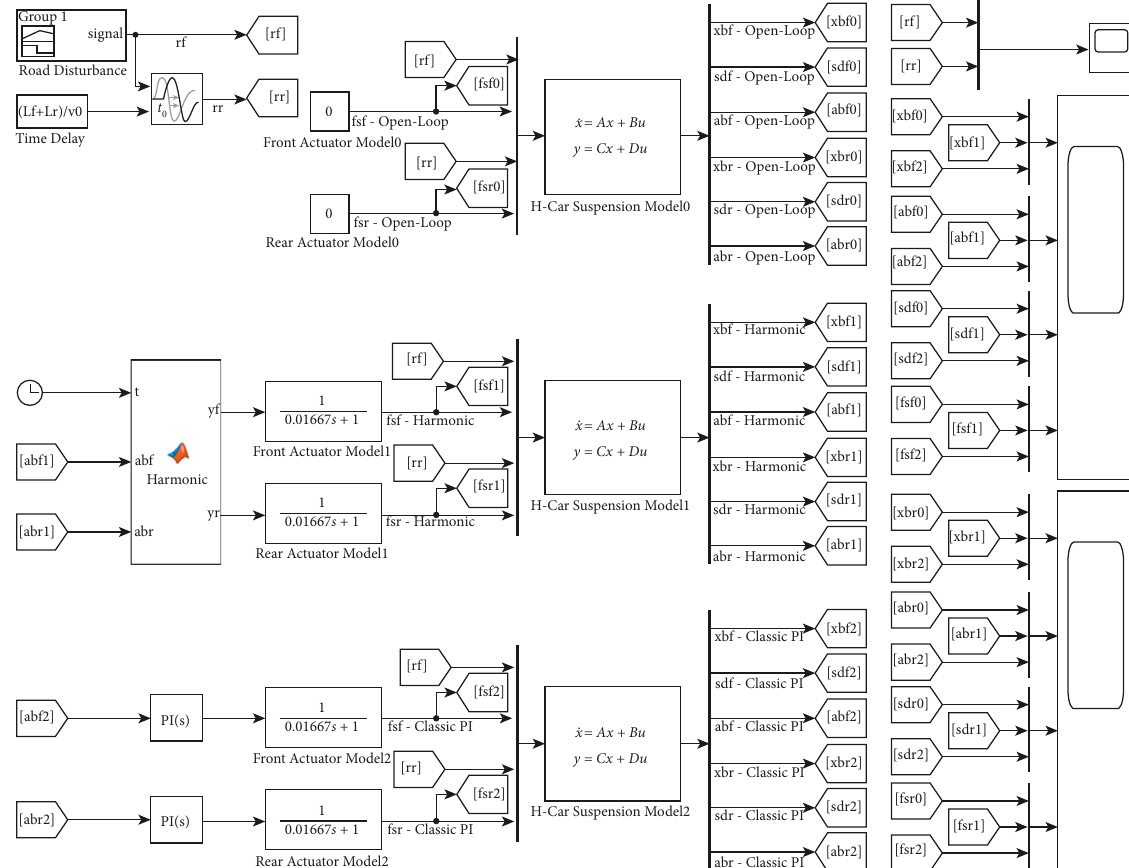
Figure 2: Simulink block diagram with the half-car active suspension